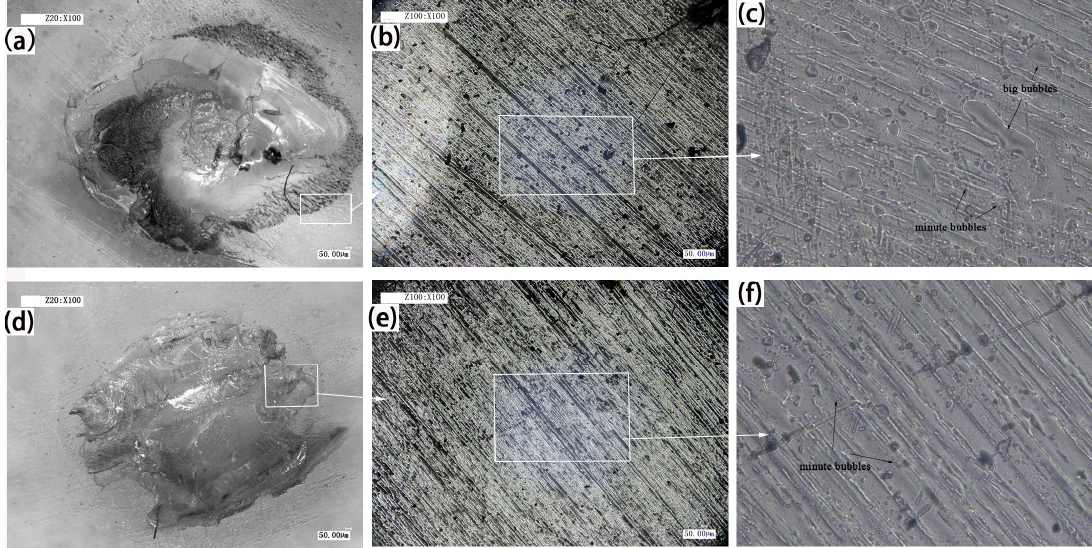
Figure 2. Weld morphology of type I, 460 V, 8 mm. ( a ) Magnified 50 times; ( b ) magnified 100 times; ( c ) magnified 500 times. Weld morphology of type II, 460 V, 8 mm; ( d ) magnified 50 times; ( e ) magnified 100 times; and ( f ) magnified 500 times.